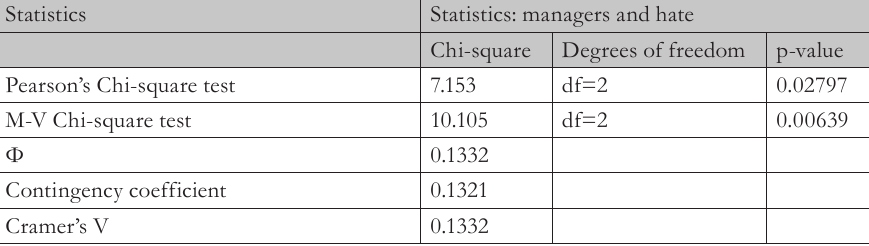
Tab. 3 – Dependence between the job position and hate. Source: own research